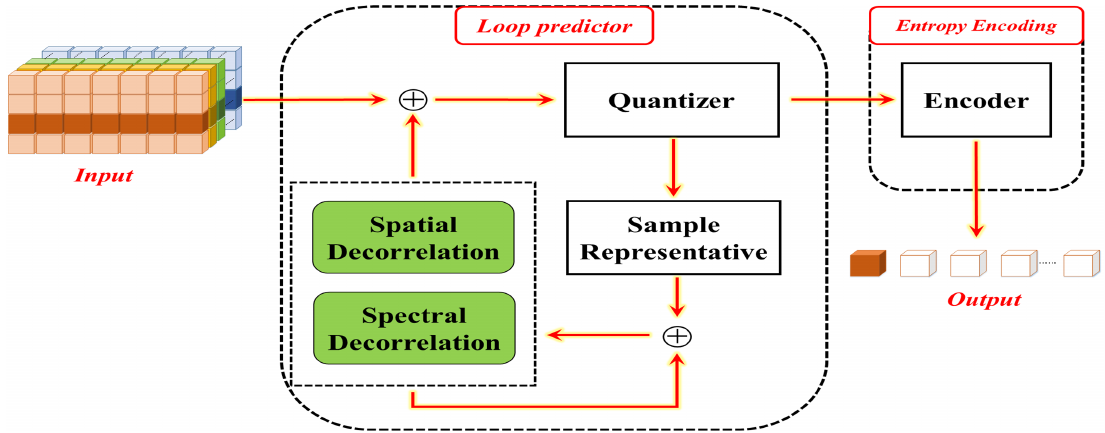
Figure 1. Compressor